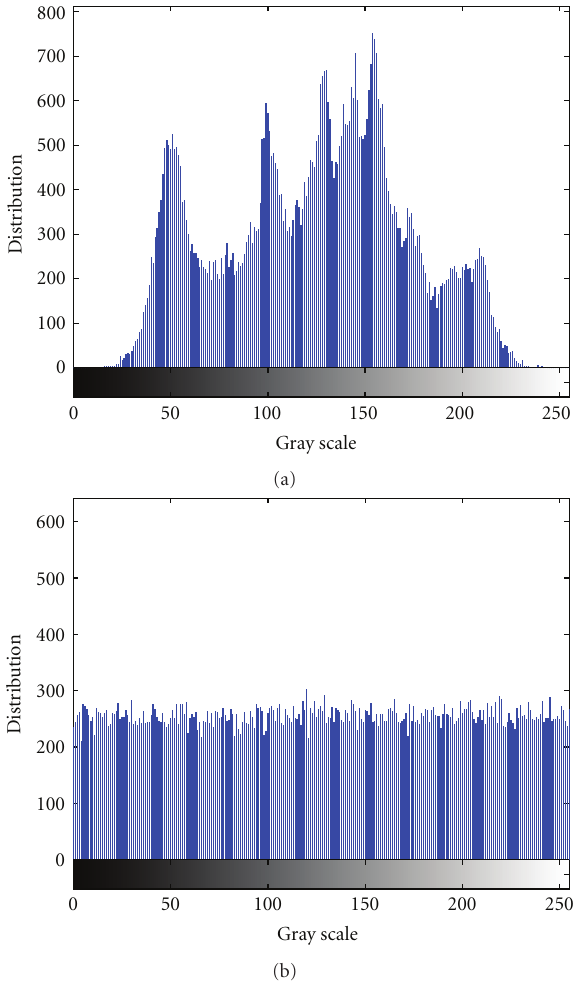
Figure 5: The grey histogram of the original image and the encrypted image. (a) The grey histogram of the original image. (b) The grey histogram of the encrypted